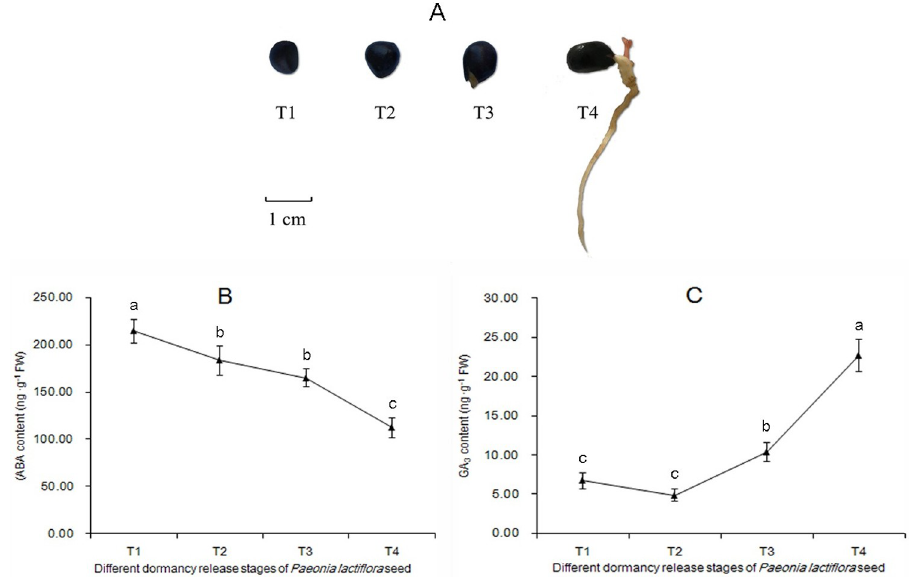
Fig 1. Observation and measurement of plant hormones across the dormancy release stages of herbaceous peony seeds. Seed dormancy release process (A), dry seed (T1); imbibition seed (T2); the radicle breakthrough seed coat (T3); the germ break out (T4). ABA content (B) and GA 3 content (C), vertical bars represent standard errors of means (n = 3). Different lower case letter (a–c) indicates the significant difference among four stages at P <